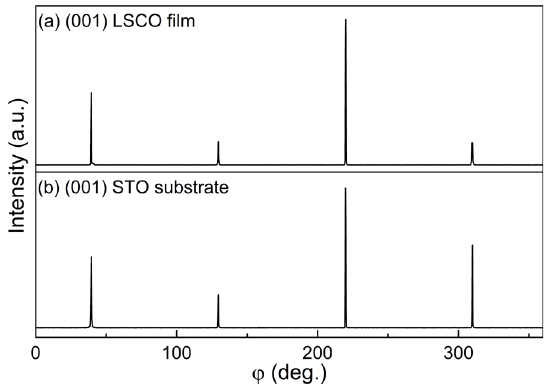
Figure 6. The in-plane ϕ -scans at (101) reflections of ( a ) LSCO thin film and ( b ) the (001) STO substrate.